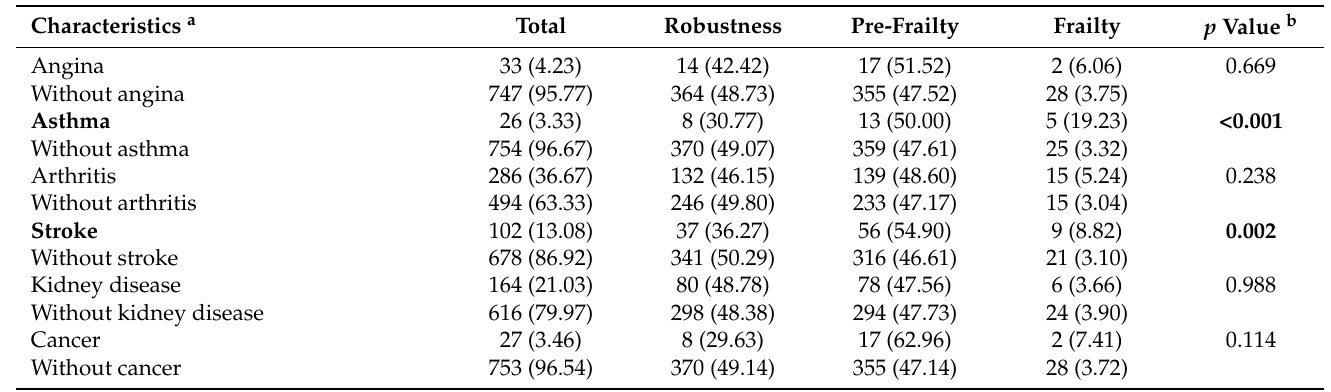
Figure 2. A posteriori dietary pattern mean sores of participants by frail status. a p -value between robust, pre-frail, and frail participants by one-way ANOVA , Bonferroni post hoc test. * p < 0.05, com- pared with the means in Robust groups. Some sex and age differences in dietary pattern scores were observed (Table 3). Fe- males got higher CHEI, DASH, and MD scores than males ( p < 0.05), while the mean score of the “protein - rich” dietary pattern was much lower in females than in males ( p < 0.01). Participants aged 65 – 69 scored higher on CHEI, DASH, and “protein - rich” diet pattern than those aged 70 – 74 ( p < 0.05). Table 3. Dietary pattern scores of participants by sex and age groups (n = 780). Dietary Pattern Score, Mean (SD)